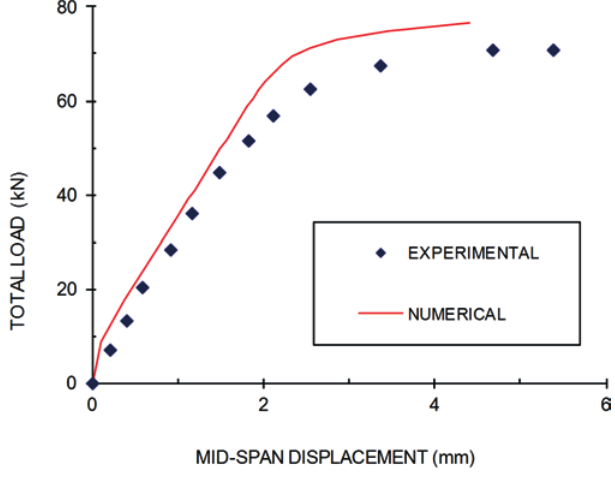
Comparison between numerical (ANEST/CA) and experimental results for frame A40 tested by Ernst et al.